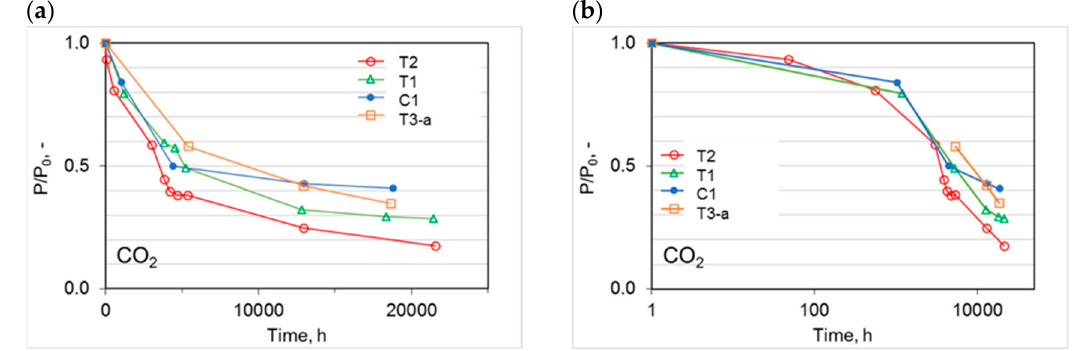
Figure 9. Time evolution of the CO 2 permeance relative to the initial value ( P 0 ) for the different HF samples: ( a ) linear plot; ( b ) semi-log plot.